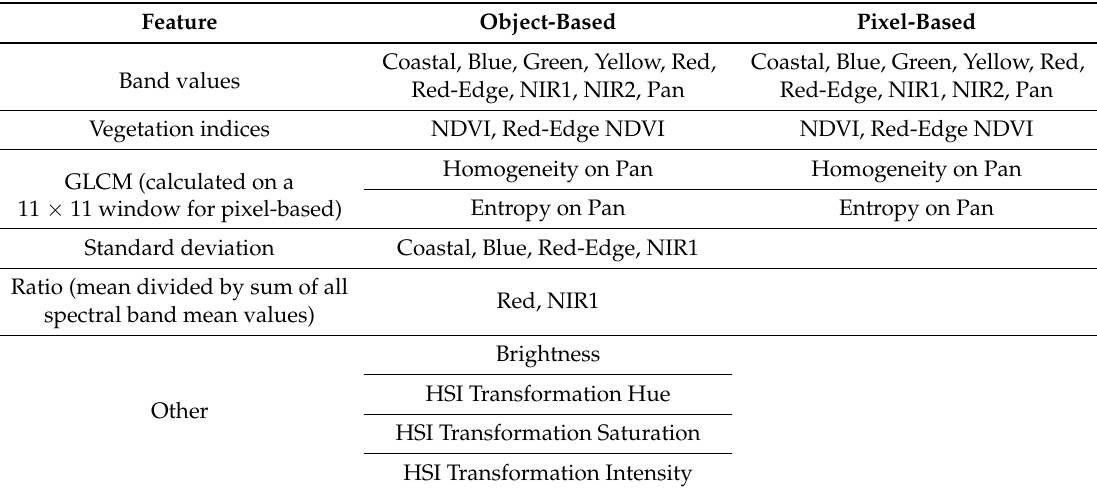
Table 4. Set of the features used for different classification algorithms. Mean value of the pixels for objects, single pixels for pixel based. Feature Object-Based Pixel-Based Coastal, Blue, Green, Yellow, Red, Coastal, Blue, Green, Yellow, Red, Band values Red-Edge, NIR1, NIR2, Pan Red-Edge, NIR1, NIR2, Pan NDVI, Red-Edge NDVI NDVI, Red-Edge NDVI Homogeneity on Pan Homogeneity on Pan Entropy on Pan Entropy on